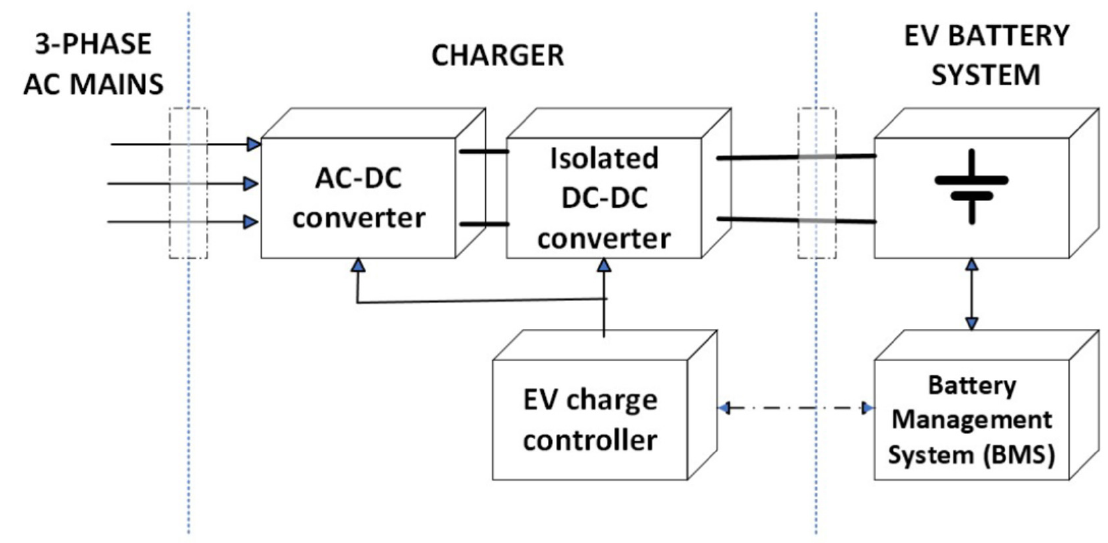
Figure 2. Offboard EV DC fast charger topology.